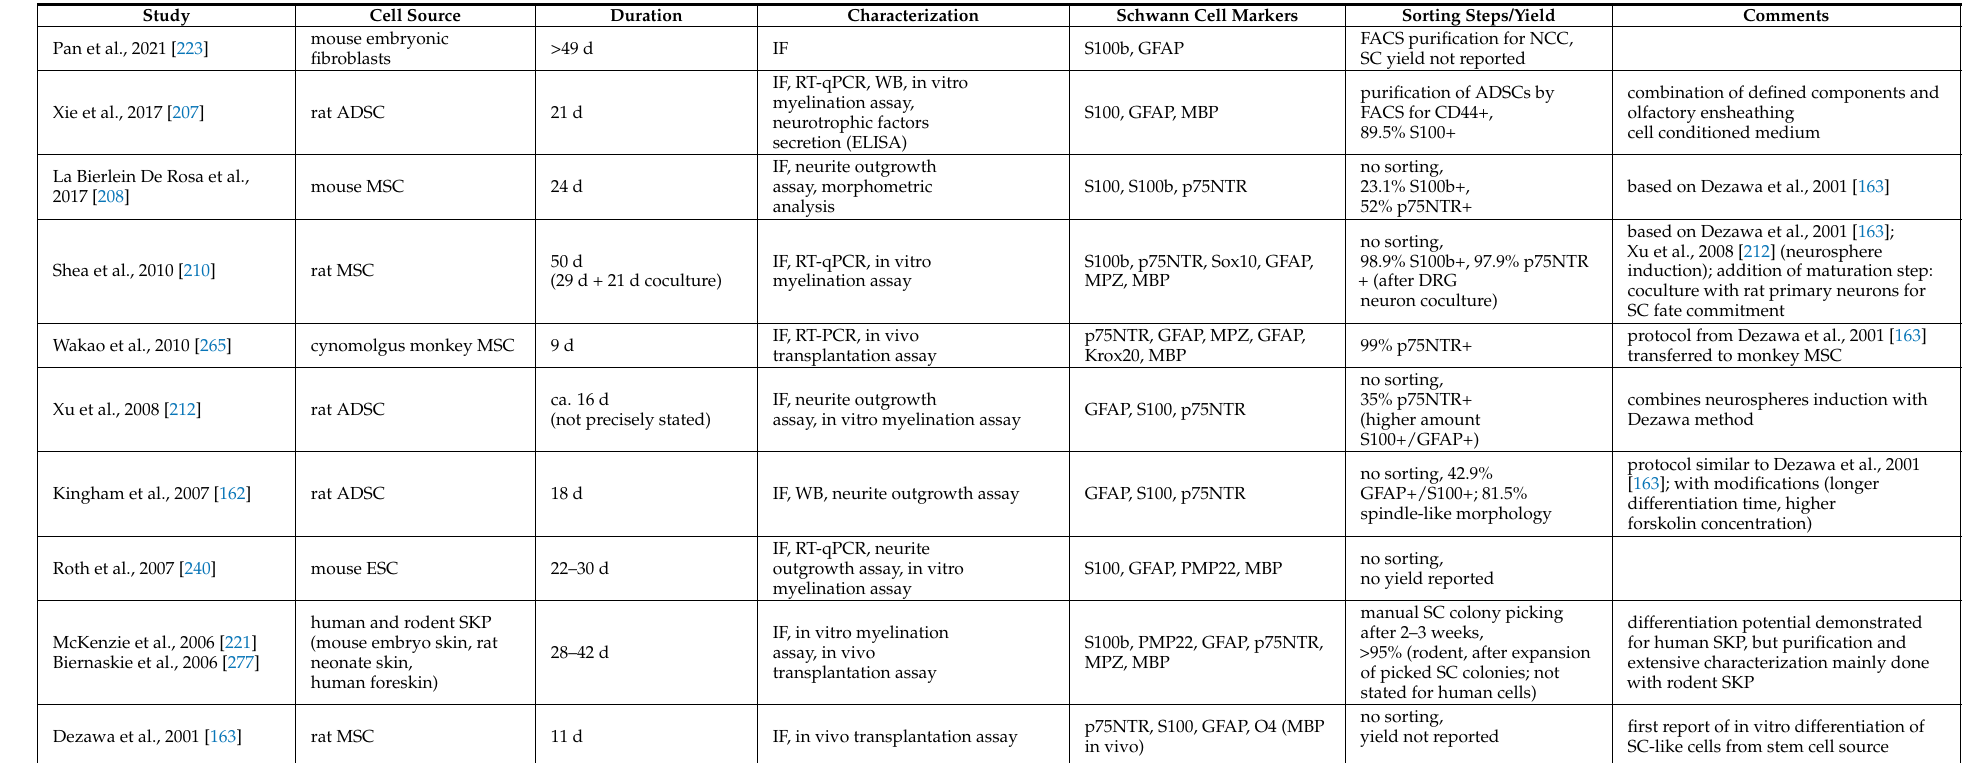
Table 4. Studies describing differentiation of Schwann cells from non-human cell sources. Sorted from most to least